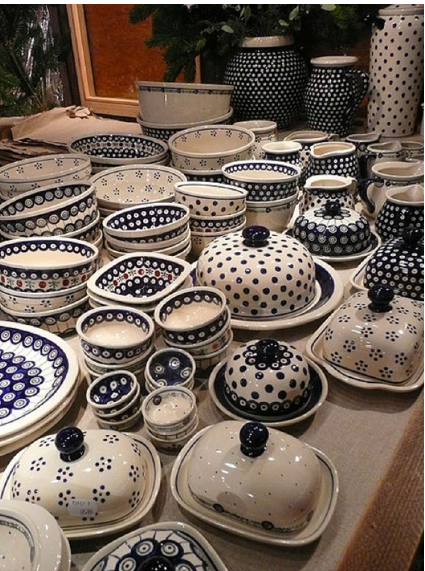
Figure 1. [Image of fine pottery]. (2009). Retrieved from https ://commo ns.wikim edia.org/wiki/File:Handg efert igte_Keram ik.JPG.